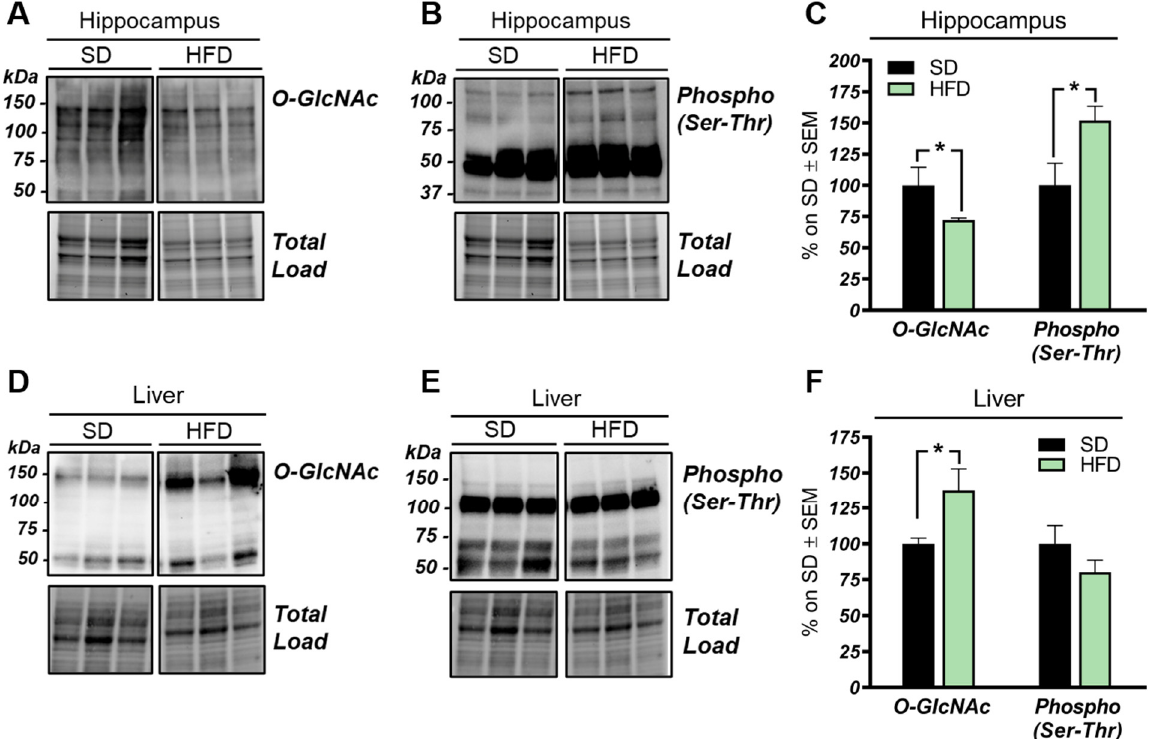
Figure 1. O-GlcNAcylation and phosphorylation profile in the hippocampus and liver from high-fat diet (HFD) mice. ( A–C ): O-GlcNAcylation/phosphorylation profile in the hippocampus from HFD mice compared to a respective standard diet (SD) animals. The reduction of protein O-GlcNAcylation in the hippocampus of HFD mice was in line with a mutual inverse increase in the global phosphorylation of serine and threonine residues compared to SD controls. Representative blots are reported in ( A , B ). ( D , E ): O-GlcNAcylation/phosphorylation profile in the liver of HFD mice compared to respective control group. Increased levels of O-GlcNAcylated proteins were observed in the liver of HFD compared to animals fed with a SD, confirming a global imbalance of O-GlcNAcylation homeostasis in peripheral organs of our model. A trend of increase was observed in the phosphorylation of serine and threonine of hepatic proteins from HFD in comparison to SD mice. Representative blots are reported in ( D , E ). Number of animals for each condition were as follow: n = 6/group for Western blot. All bar charts reported in ( C , F ) show mean ± SEM. * p < 0.05, using Student’s t test.